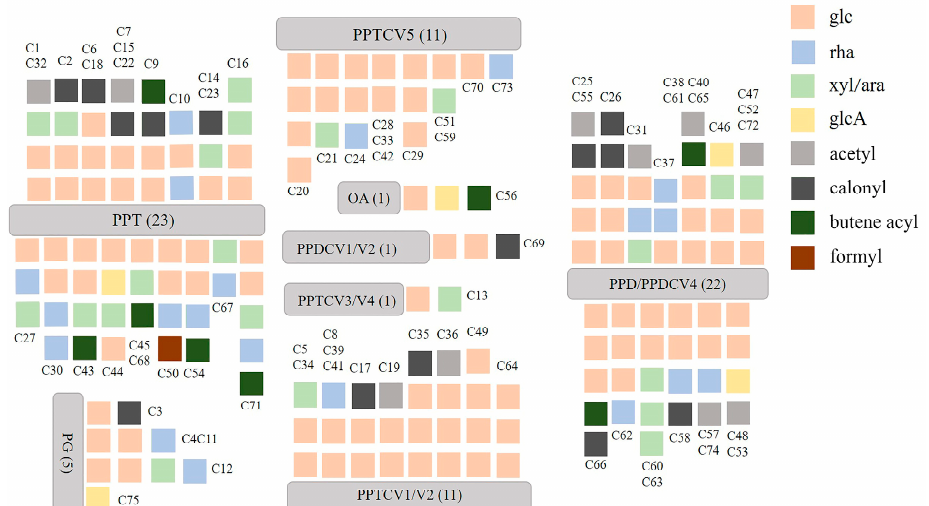
Figure 2. Structure analysis of 75 potential new ginsenosides.